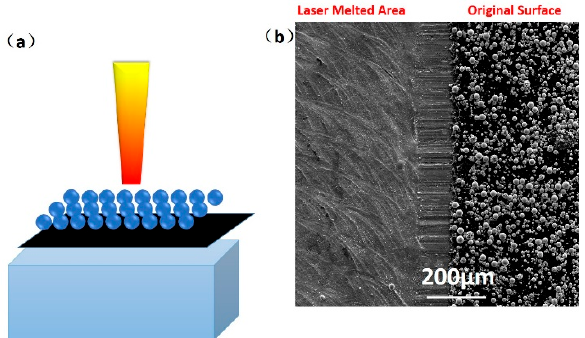
Figure 1. An illustration of the single-layer powder selective laser melting (SLM) experiment ( a ). The top surface appearance after and before laser scanning is shown by a divided scanning electron microscope (SEM) image with left and right areas, respectively ( b ).